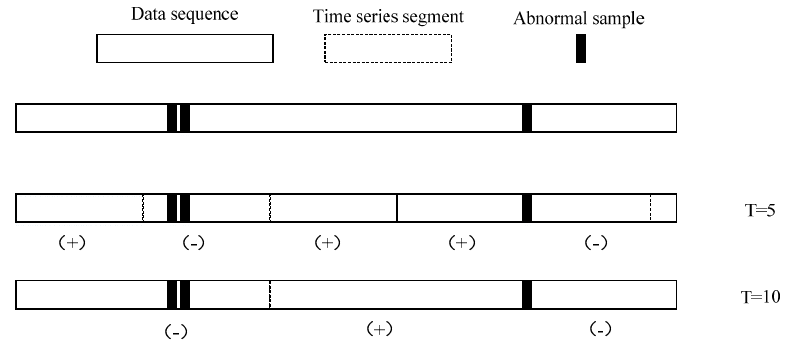
Figure 8. Time series generation with different length. Mark (+) denotes the normal series and mark ( − ) denotes the abnormal series.